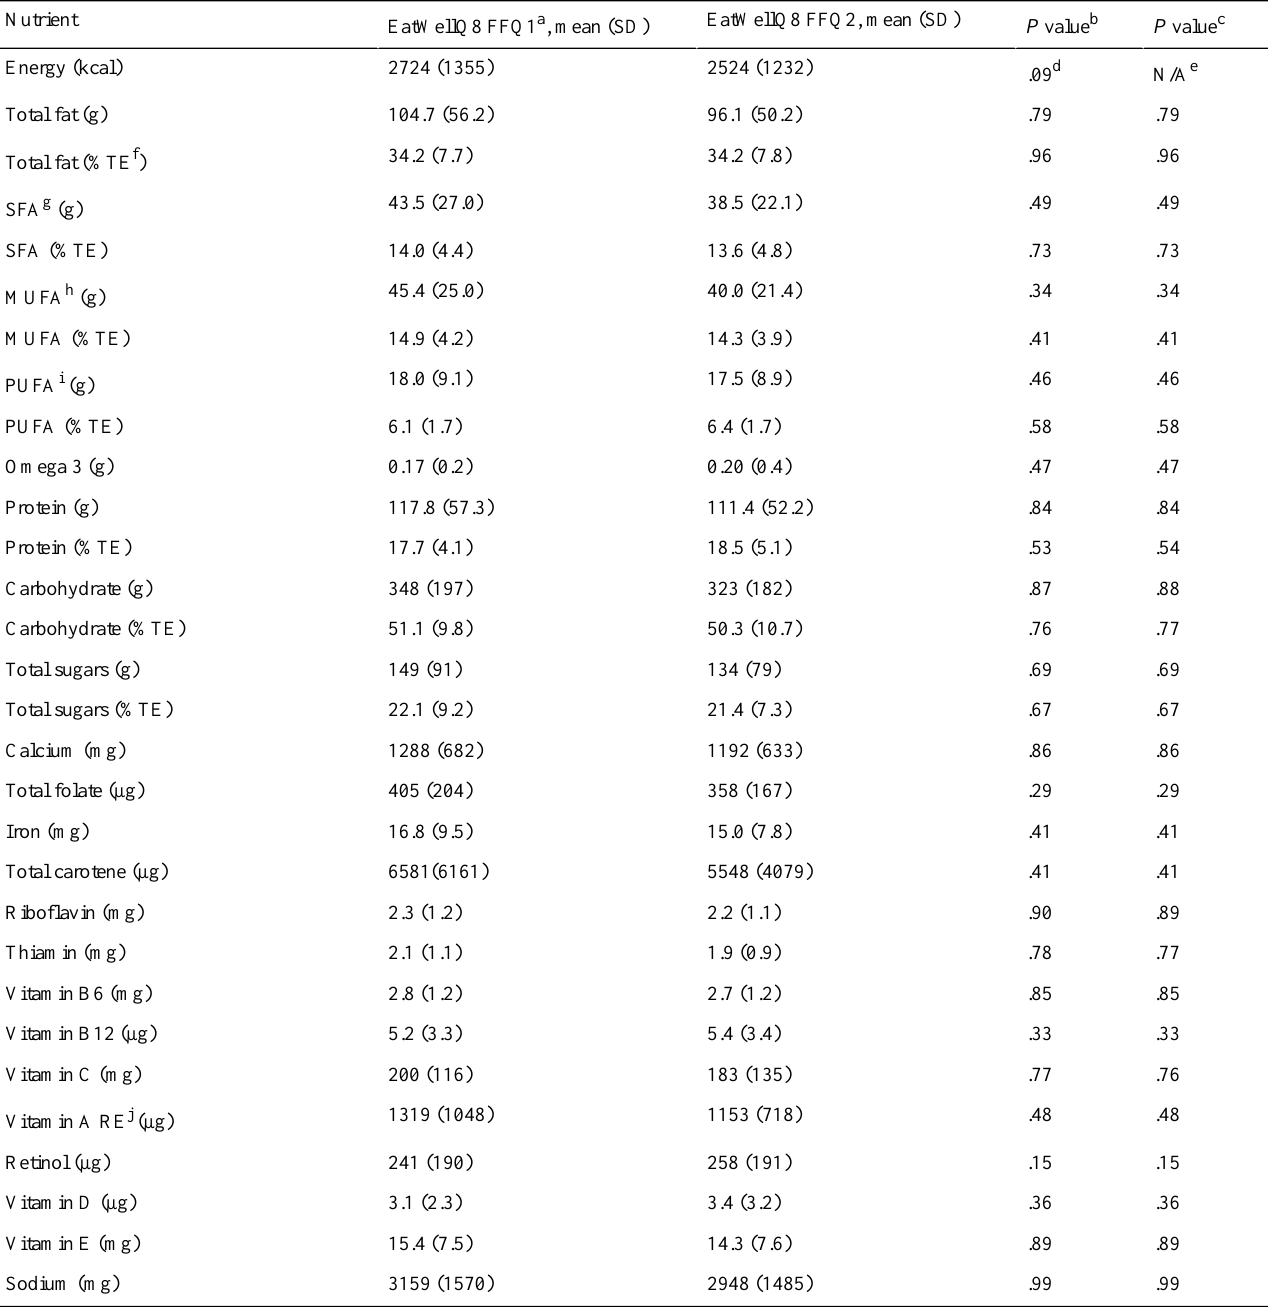
Table 2. Mean daily energy and nutrient intakes estimated by repeated measures of the web-based EatWellQ8 food frequency questionnaire